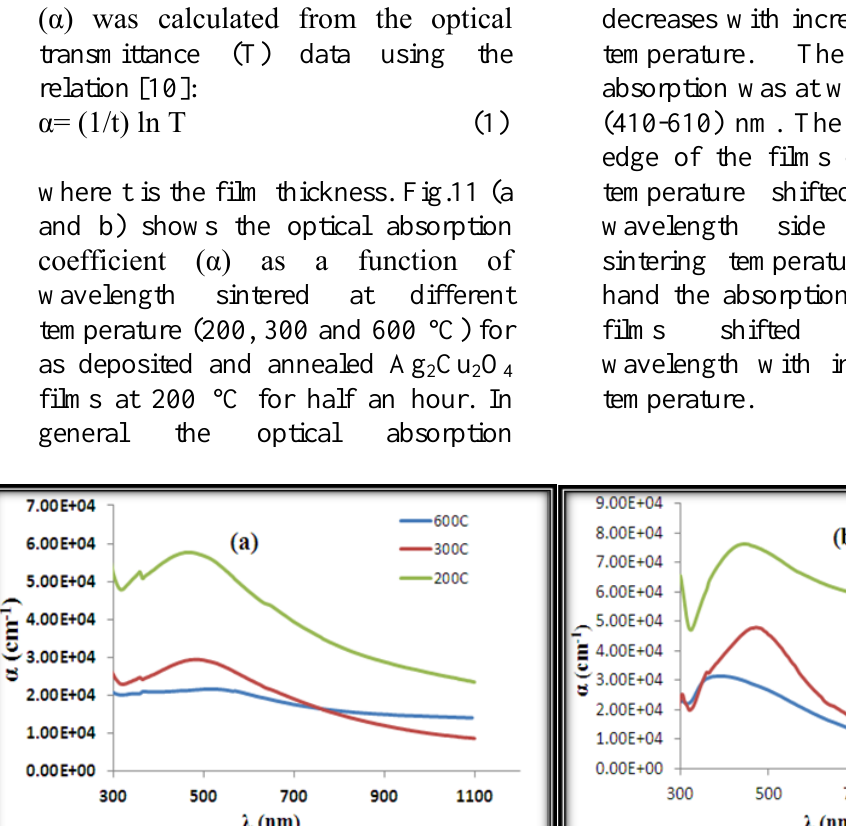
Fig.10: Optical transmittance versus wavelength of Ag different temperature (a) as deposited (b) annealed at 200°C for half an hour.